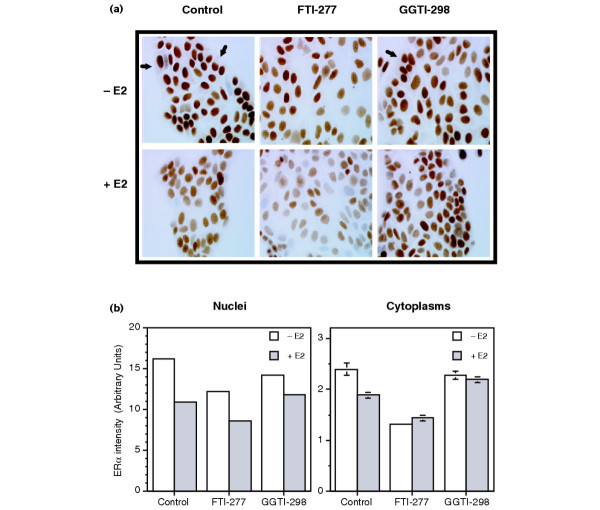
Immunocytochemical analysis of the effects of prenyltransferase inhibitors on estrogen receptor (ER) α distribution in MCF-7 cells. (a) Cells, deprived of estradiol (E2) for 7 days, were treated or not with FTI-277 (10 μM or dithiothreitol/dimethylsulfoxide vehicle), and 24 hours later they were stimulated with E2 (5 nM) or ethanol and treated or not with FTI-277 or GGTI-298 (10 μM or 5 μM, respectively, or vehicle). After 24 hours, cells were fixed and stained. One randomly selected field is presented for each treatment. (b) Data were quantified by determining the grey value of both the nucleus and the cytoplasm for each cell counted, as described in Materials and methods. For each experimental condition, six randomly selected fields were analyzed. The total number of cells present in the fields ranged from 250 to 400. Error bars indicate the mean values ± standard error of the mean, and the results are representative of two independent experiments.